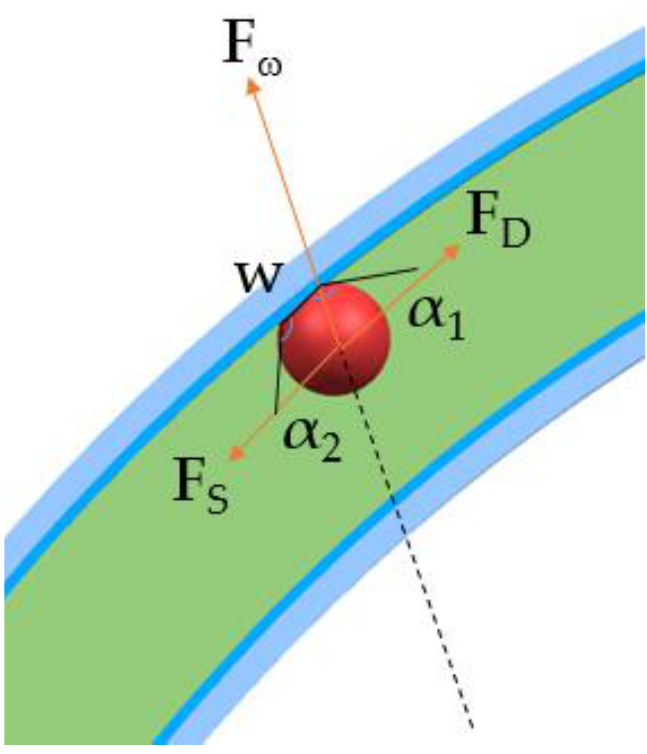
Figure 3. The force analysis of droplet movement.